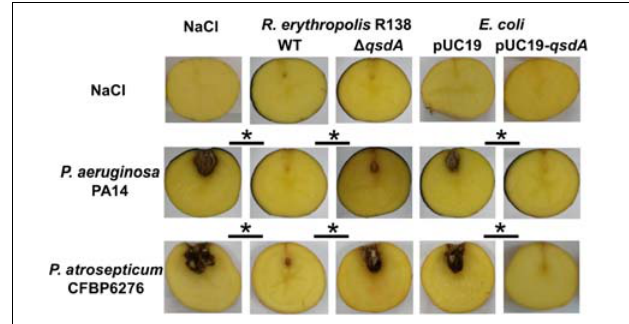
FIGURE 1 | Anti-virulence activity of Rhodococcus erythropolis and QsdA lactonase expressing E. coli strains against AHL-producing Gram-negative pathogens. Quorum quenchers and their corresponding control strains ( R. erythropolis (cid:49) qsdA mutant strain defective in QsdA lactonase production and E. coli pUC19) were compared for biocontrol activity against a 3-oxo-C 12 -HSL and C 4 -HSL producer, the human pathogen P. aeruginosa PA14, as well as a 3-oxo-C 8 -HSL producer, the potato pathogen Pectobacterium atrosepticum CFBP6276. Seven days after inoculation in potato tubers, tissue necrosis or soft-rot due to P. aeruginosa and P. atrosepticum , respectively, were analyzed and compared between tuber lots (black bars). For the controls, one or both strains were replaced in the inoculum with a 0.9% NaCl solution. Significant differences (Mann and Whitney test; p -value < 0.01) in maceration symptoms between infected tubers inoculated with control and quorum quencher strains are indicated with an